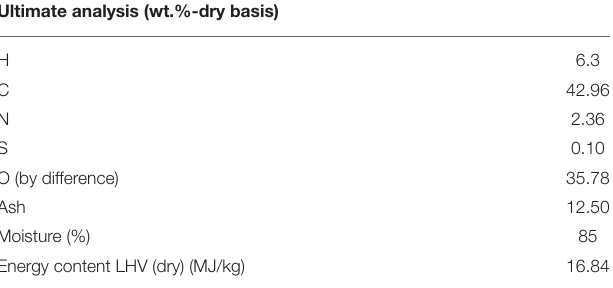
TABLE 3 | Ultimate analysis of fecal sludge.